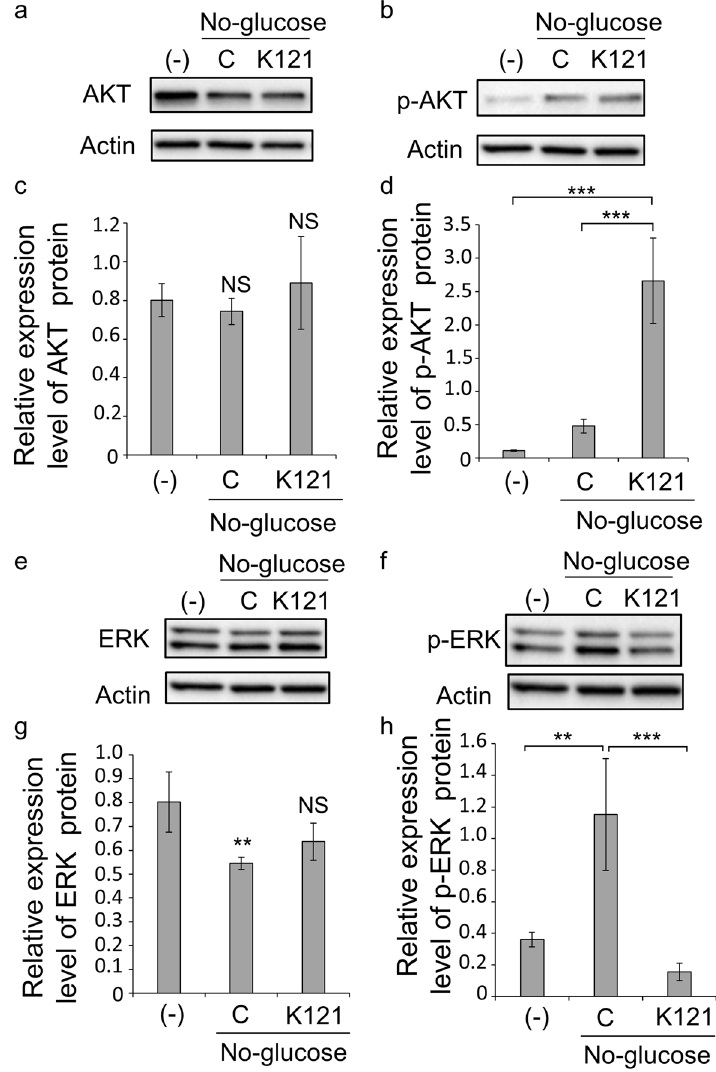
Figure 8. AKT, p-AKT, ERK and p-ERK protein expression in 661W cultured cells under glucose-free conditions. ( a – d ) Protein expression of AKT ( a,c ) and p-AKT ( b,d ) in 661W cells was analyzed by western blotting. Actin was used as a loading control. Complete scans of western blots are shown in Supplementary Fig. S3a,b. (-): cultured in high-glucose media, C: cultured with glucose-free media without KUS121, K121: cultured with glucose-free media with KUS121 (100 µM). Relative expression of AKT( c ) and p-AKT ( d ) is shown as a ratio to actin ( n = 4, for both treatments). NS: no significant difference compared with (-) (in c ), *** p < 0.001, compared with cells cultured in glucose-free media with KUS121 (in d ), Tukey’s HSD. ( e – h ) Protein expression of ERK ( e , g ) and p-ERK ( f , h ) in 661W cells was analyzed by western blotting. Actin was used as a loading control. Complete scans of western blots are shown in Supplementary Fig. S4a,b. (-): cultured in high-glucose media, C: cultured with glucose-free media without KUS121, K121: cultured with glucose-free media with KUS121 (100 µM). Relative expression of ERK ( g ) and p-ERK ( h ) is shown as a ratio to actin ( n = 4, for both treatments). ** p < 0.01, NS: no significant difference compared with (-) (in g ), ** p < 0.01, *** p < 0.001, compared with cells cultured in glucose-free media without KUS121 (in h ), Tukey’s